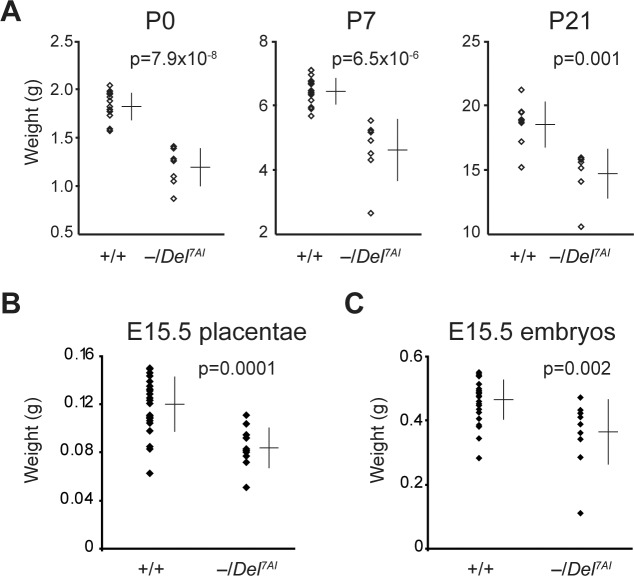
Growth retardation of rescued Ascl2lacZ/Del7AI heterozygotes.(A) Scatterplots showing weights of rescued live Ascl2lacZ/Del7AI pups (–/Del7AI, n = 7) and their wild-type littermates (n = 14) at postnatal days 0 (P0, birth), 7, and 21. Scatterplots of E15.5 placental (B) and embryonic (C) weights of Ascl2lacZ/Del7AI conceptuses (–/Del7AI, n = 10) and wild type littermates (n = 25). In all graphs, the bars show the average weight ± SD.